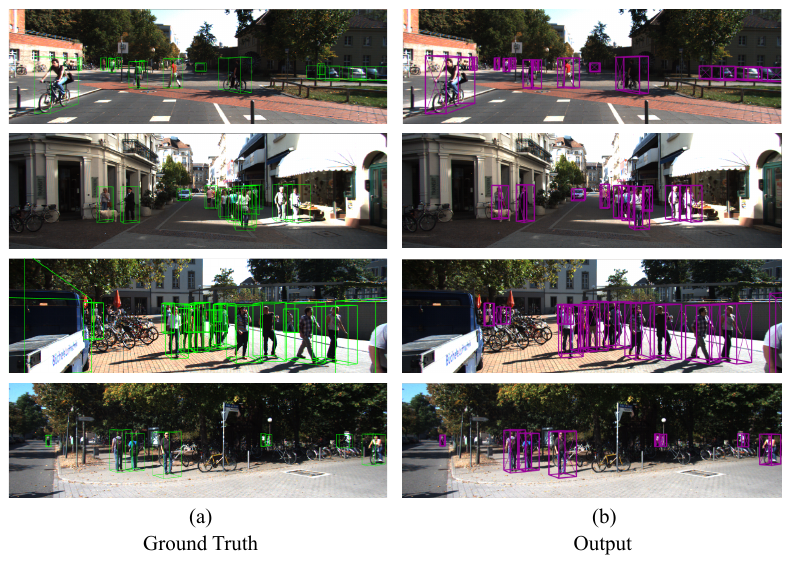
Figure 6. Visualization of multi-class detection for pedestrians and cyclists in four scenes. In each picture group, we show the ground-truth ( a ) and the output ( b